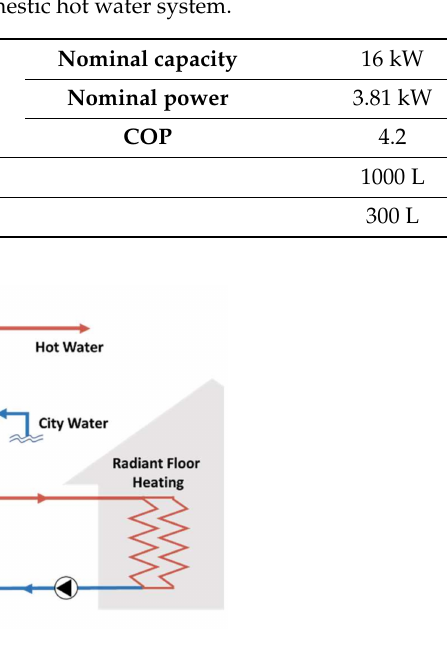
Figure 3. Schematic diagram of space heating and domestic hot water